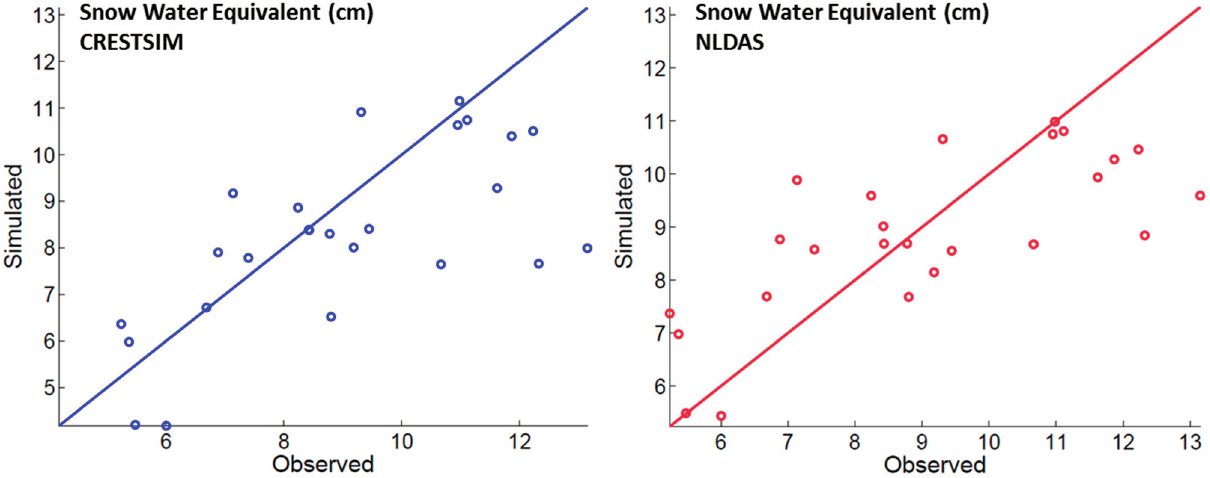
Figure 7. SWE Scatter Plot (winter 2011–2012) for both simulated scenarios: ( left ) CRESTSIM; and ( right )